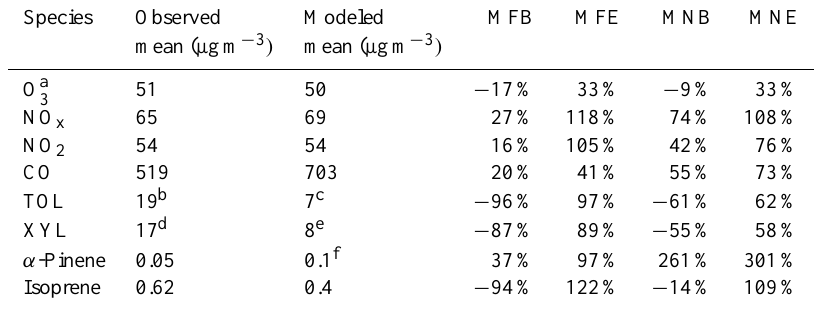
Table 5. Statistical performance evaluation for O 3 , NO 2 , NO x , CO and some VOC at USJ for the simulation A4.